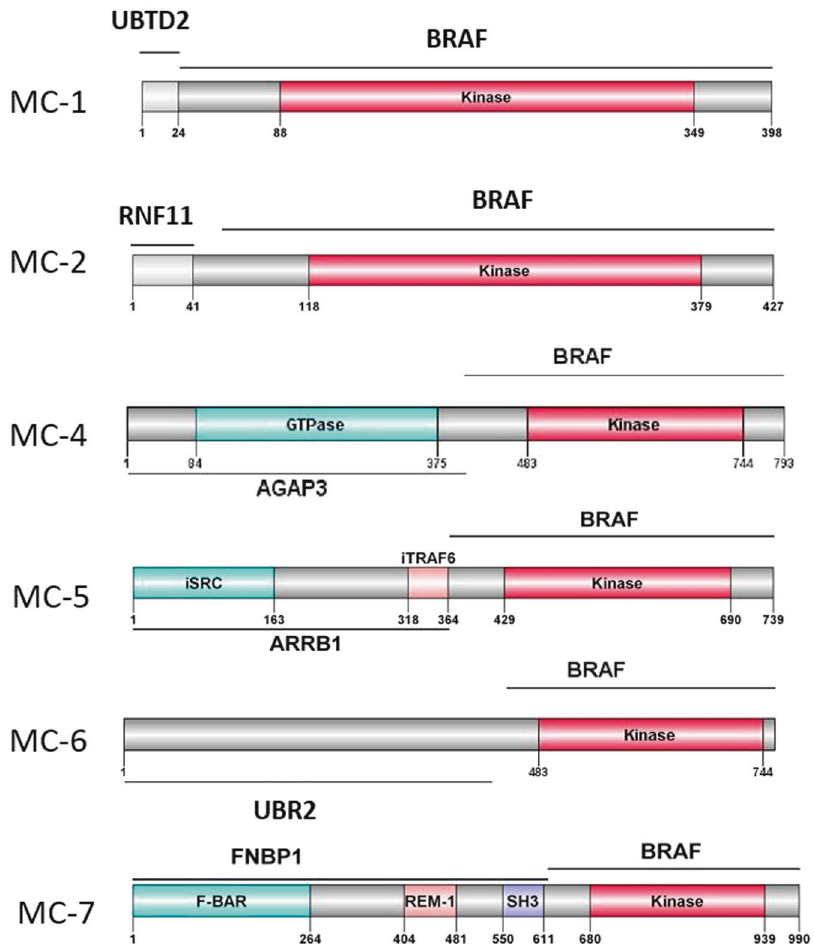
Fig. 1 Locations of BRAF fusion. Patients in the Mayo Clinic cohort with BRAF fusions were noted to have preserved kinase domain